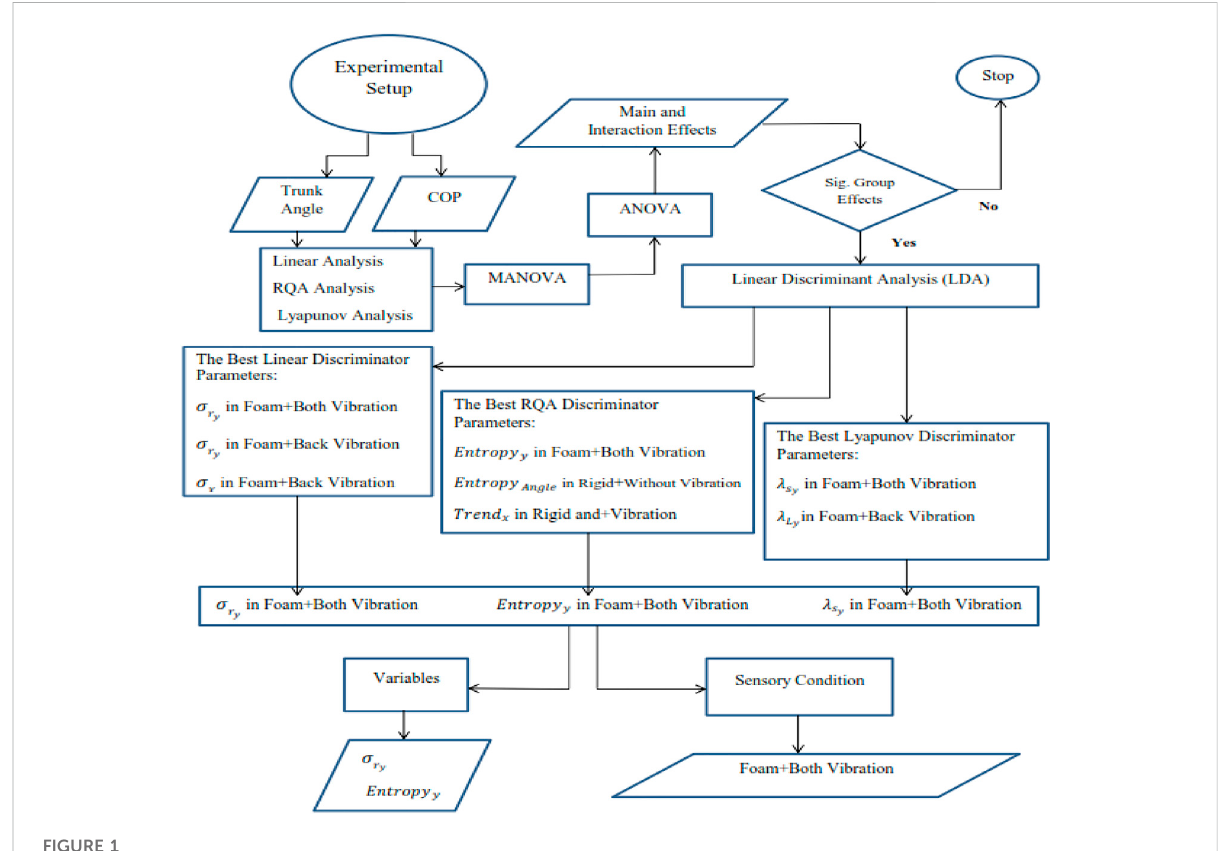
FIGURE 1 Flow chart of statistical analysis.